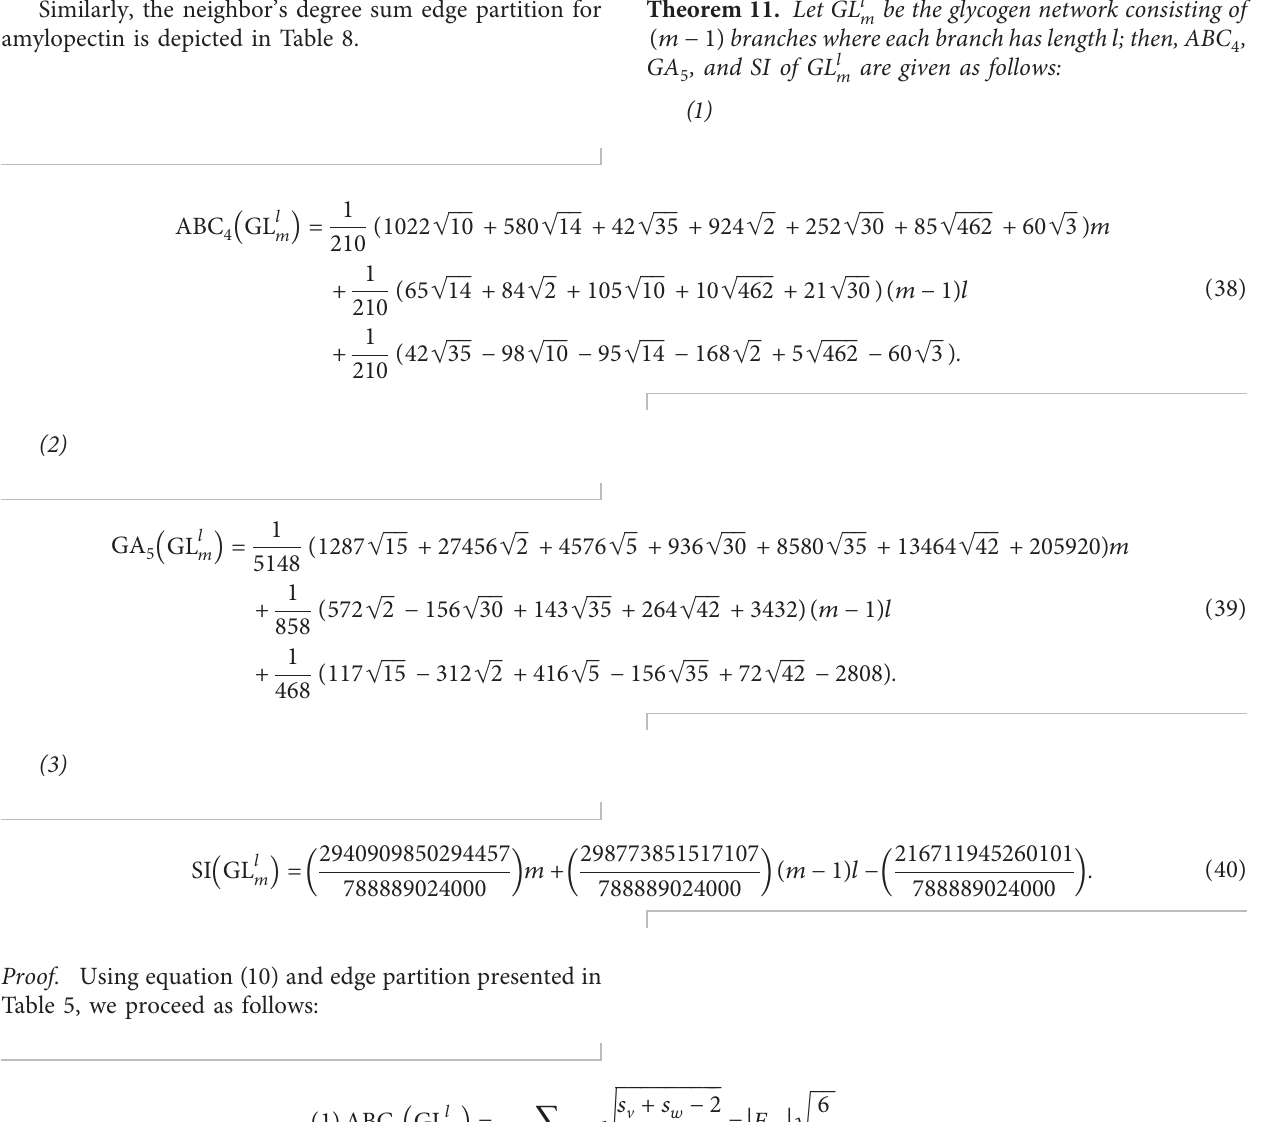
Table 8: Partitioning of the edge set with respect to neighbor’s degree sum of end vertices for AM l ,s ) : vw ∈ E ( AM l ) Number of ( s v w m